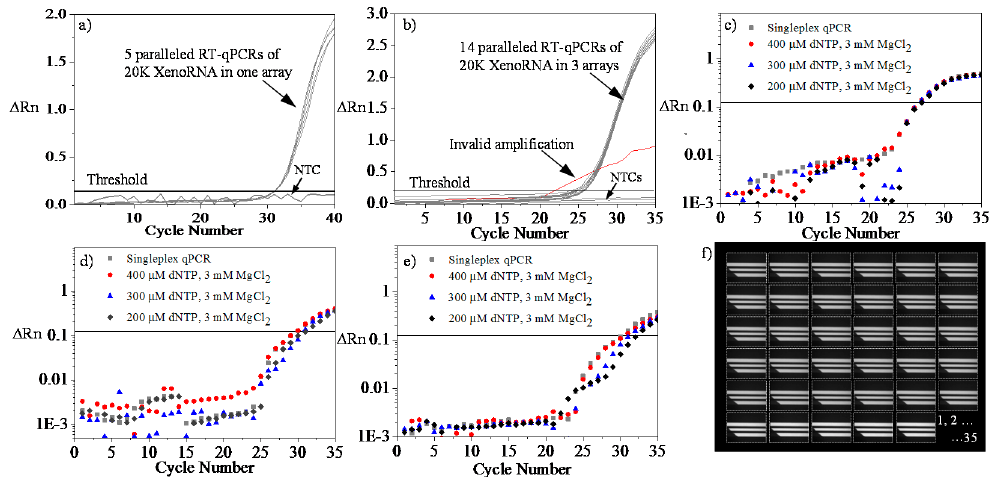
Figure 4. ( a ) Repeatability or intra-assay variation testing of microfluidic RT-qPCR (20,000 copies XenoRNA); ( b ) Reproducibility or inter-assay variation testing of microfluidic RT-qPCR; ( c ) On-chip PCR of GAPDH by singleplex or multiplex methods; ( d ) On-chip PCR of CDKN1A by singleplex or multiplex methods; ( e ) On-chip PCR of AURKA by singleplex or multiplex methods (square points mean the data by singleplex method while the circle, triangle and diamond symbols mean the data by multiplex tests); and ( f ) A fluorescent image set reflecting CDKN1A reporter intensity during a 35-cycle qPCR (Numbered as 1, 2, …, 35).